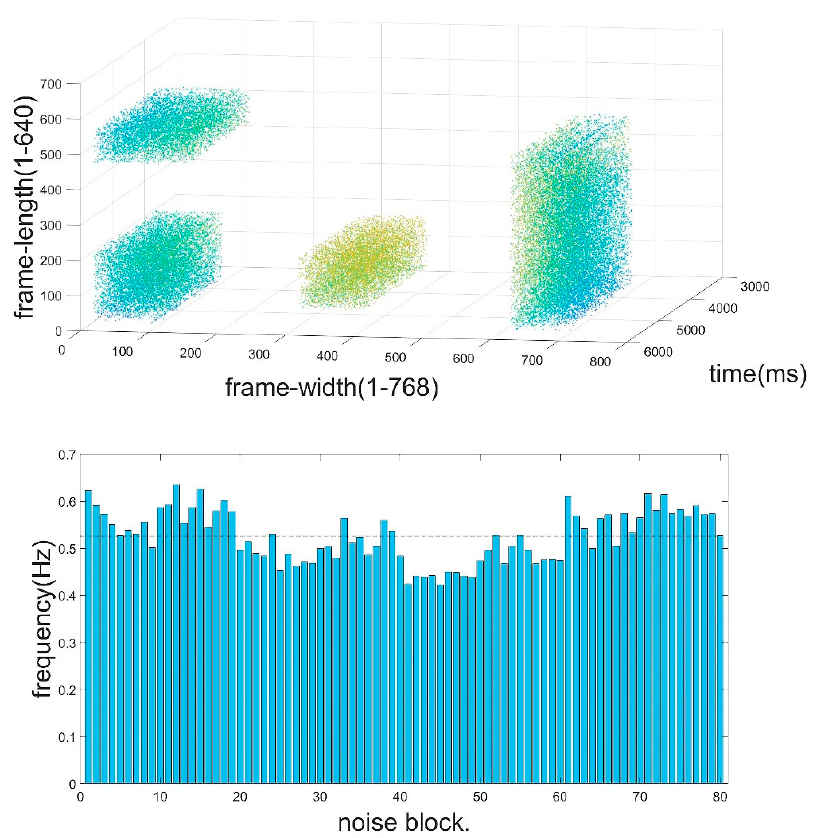
Figure 4. Sampled background activity (BA) events ( top ) and statistical histogram ( bottom ).